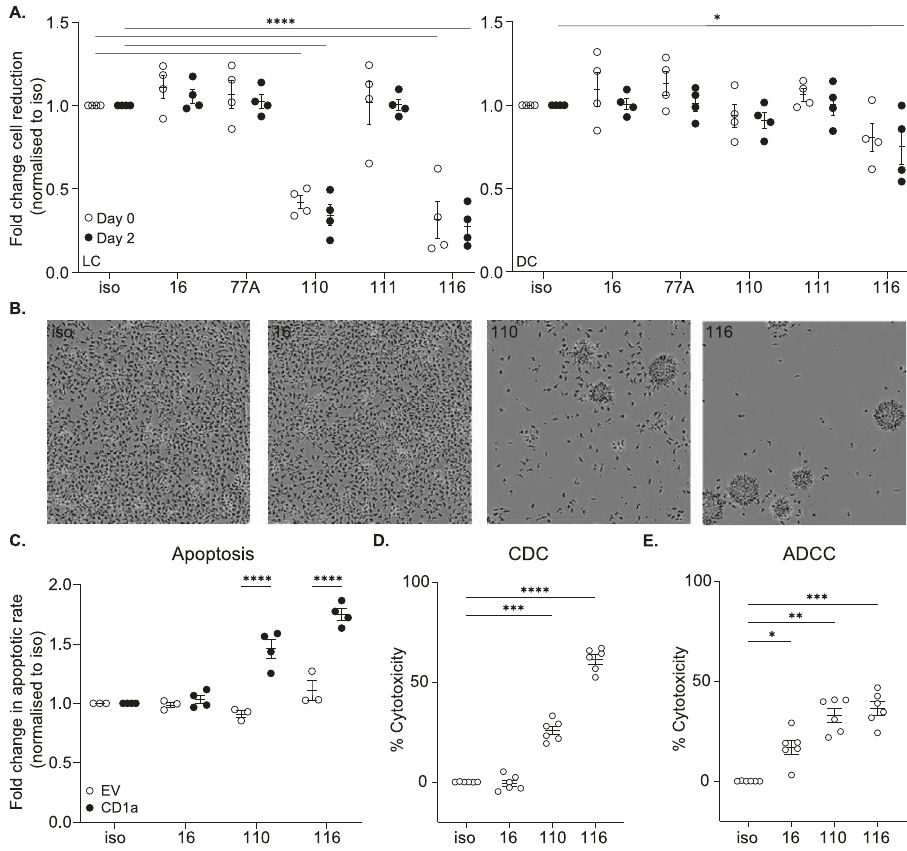
Fig. 5 | Analysis of anti-CD1a-antibody-induced phenotype change and cyto- toxicity. A Anti-CD1a antibodies or mouse IgG1 isotype control (iso, 5 µ g/ml) were incubatedwithmonocyte-derivedLangerhanscells(LC)(leftpanel)andmonocyte- derived dendritic cells (DC) (right panel) as indicated for 5 days with antibodies addedonday0orday2andfoldchangeincellculturecon fl uencywascalculatedin relation to the isotype control as measured by percentage con fl uence using Incu- cyte live cell imaging. n =4 biologically independent blood monocyte donors examined over 2 independent experiments. Two-way-ANOVA with Dunnett ’ s mul- tiple comparisons test, * P <0.05, **** P <0.0001, mean±SEM. B Representative images of monocyte-derived LCs. data shown representative of 2 independent experiments. C K562-CD1a (CD1a) or K562-Empty vector (EV) were incubated with anti-CD1a antibodies for 24h and stained for Annexin V and analyzed by fl ow cytometry. n =4 independent cultures ofK562cells, examinedover2independent experiments. D Flow cytometric analysis of complement-dependent cytotoxicity (CDC). K562-CD1a cells were incubated with 10% normal human serum for 3h